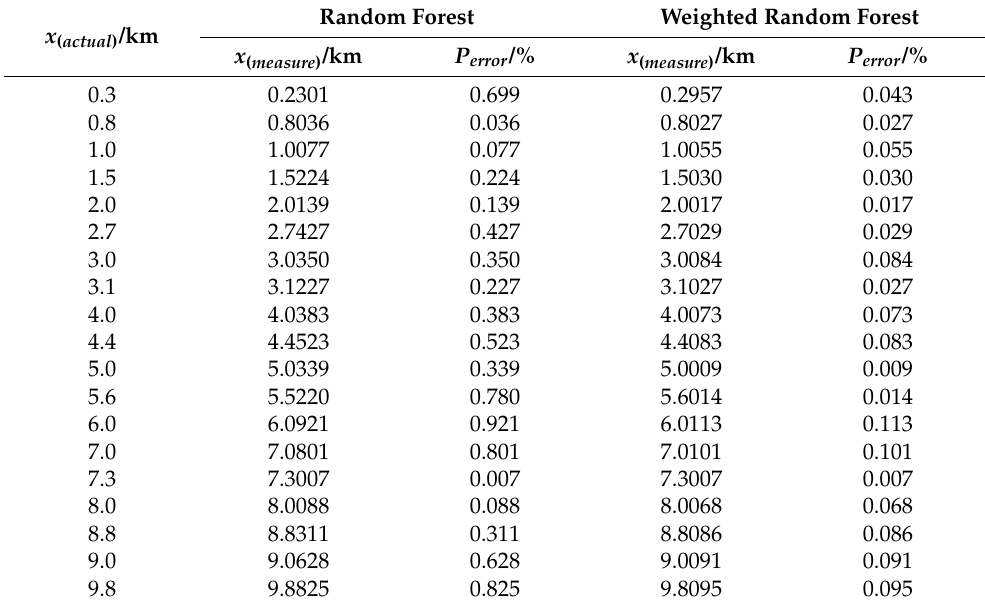
Table 4. Fault location results and